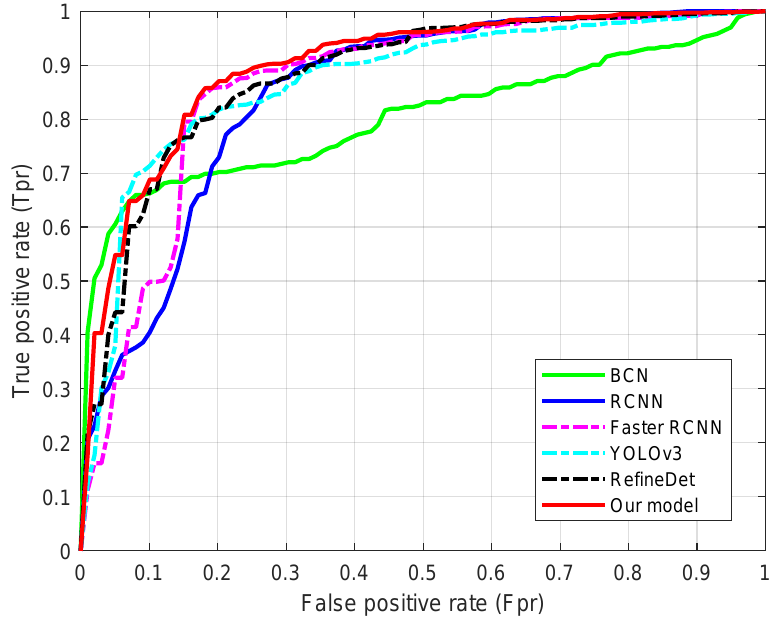
Figure 9. Receiver operating characteristics (ROC) curves of the compared